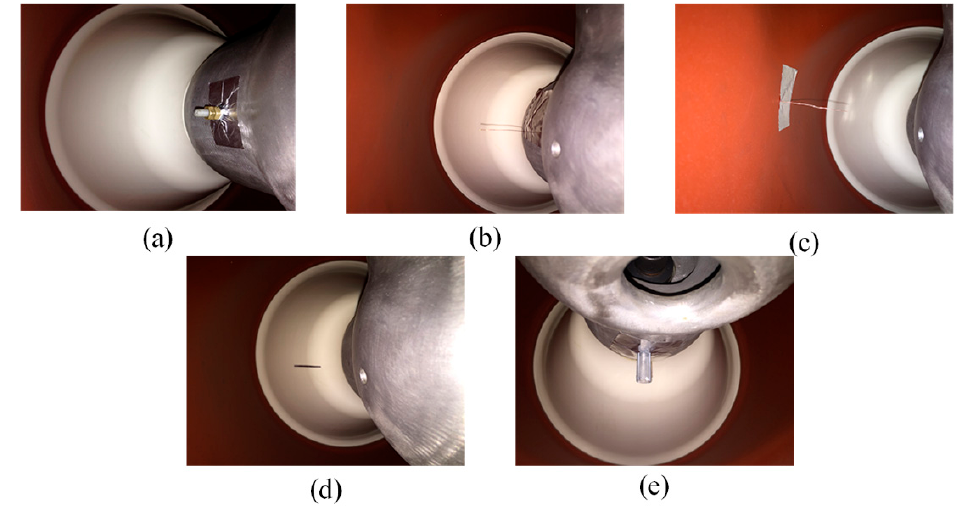
Figure 10. Typical PD defect patterns: ( a ) floating electrode; ( b ) metal protrusion on the conductor; ( c ) metal protrusion on the tank; ( d ) surface contamination; ( e ) free metal particles.